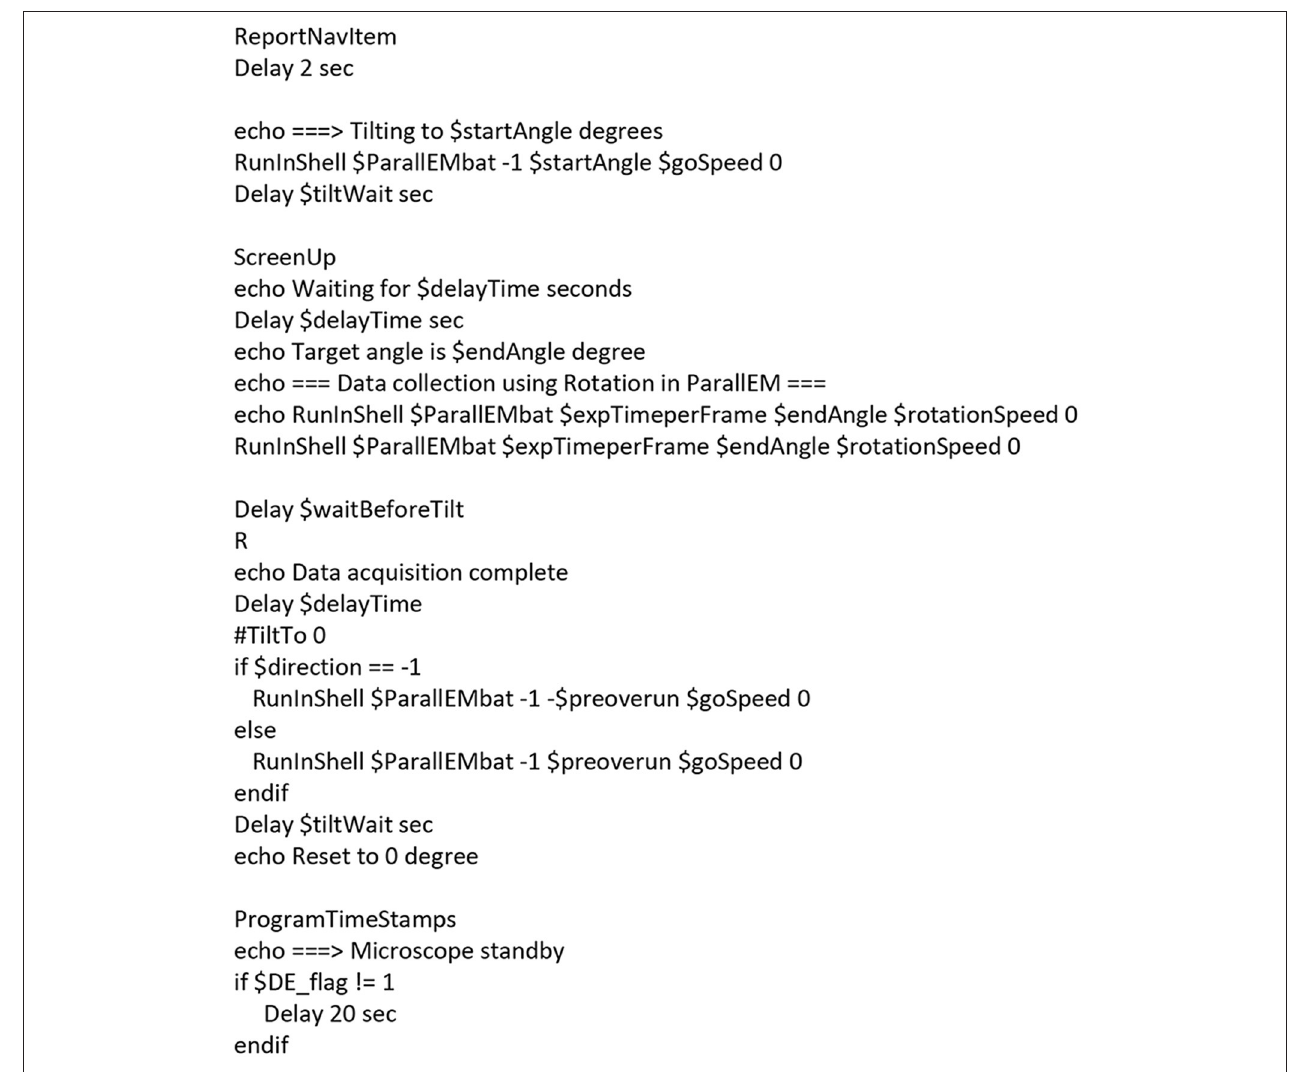
FIGURE 2 | A SerialEM script for rotational data collection on the DE64. The script calls Rotation in ParallEM (Takaba et al., 2020) and can also be used for the XF416 without its camera control software EMMENU. The code is available as Supplementary Material 1